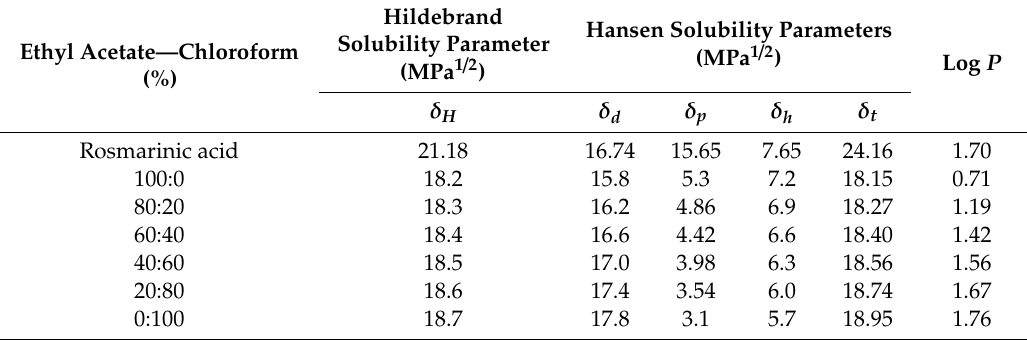
Table 3. Solubility parameters of rosmarinic acid and solvent